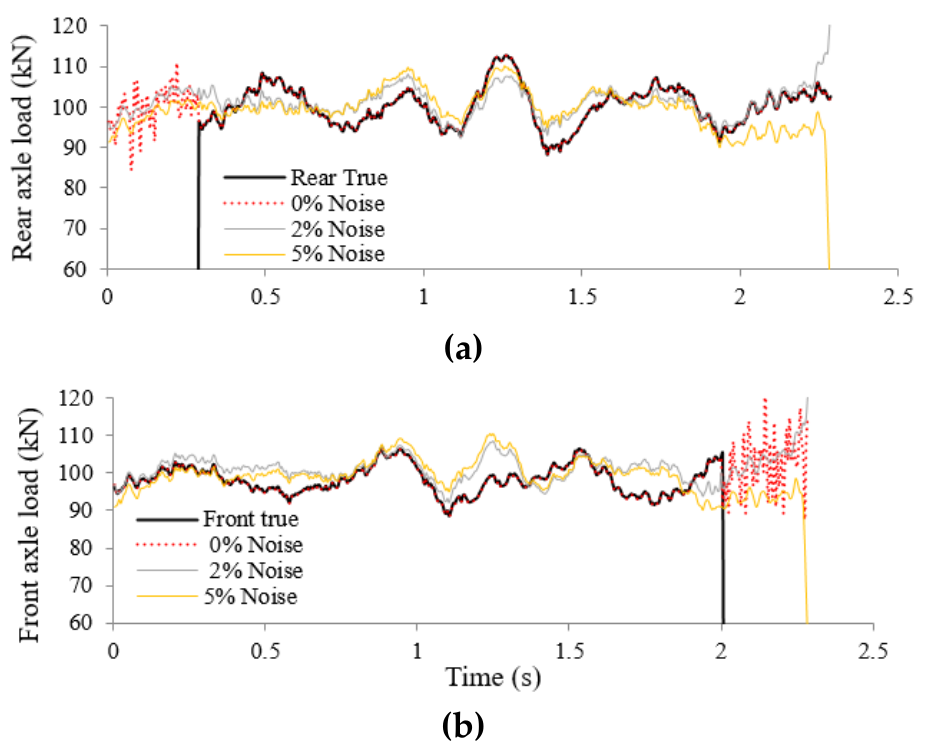
Figure 5. Identified loads at road roughness level A with speed 15 m/s using sensor placement S7. ( a ) Rear axle load identification, ( b ) Front axle load identification.